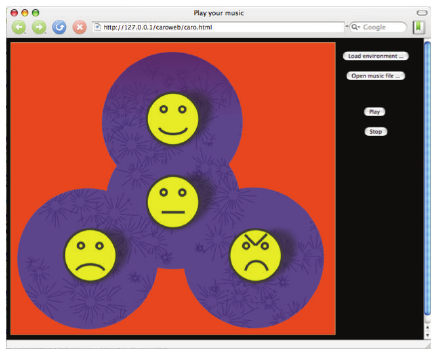
Figure 6: The options window (designed for musicians) that allows the fine tuning of the model. For general public, it is possible to load preset configurations (see the button “load parameters from file”).